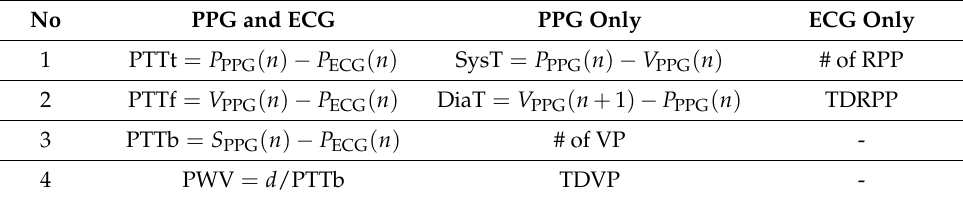
Table 1. Feature extraction information. Abbreviations; pulse transit time (PTT), PTTtop